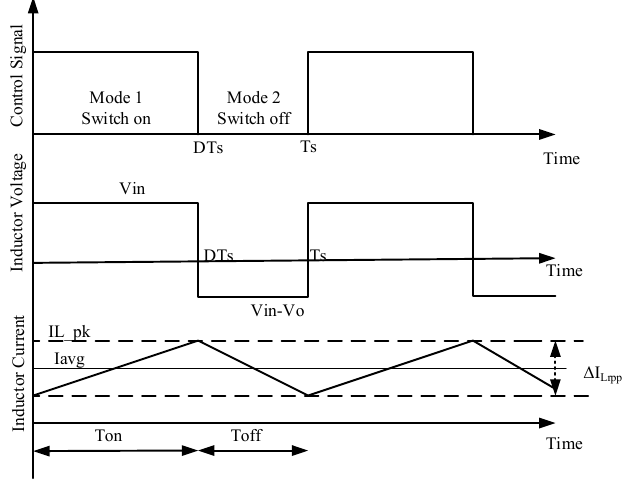
Figure 3. Boost inductor voltage and currents waveforms of the conventional PFC topology.